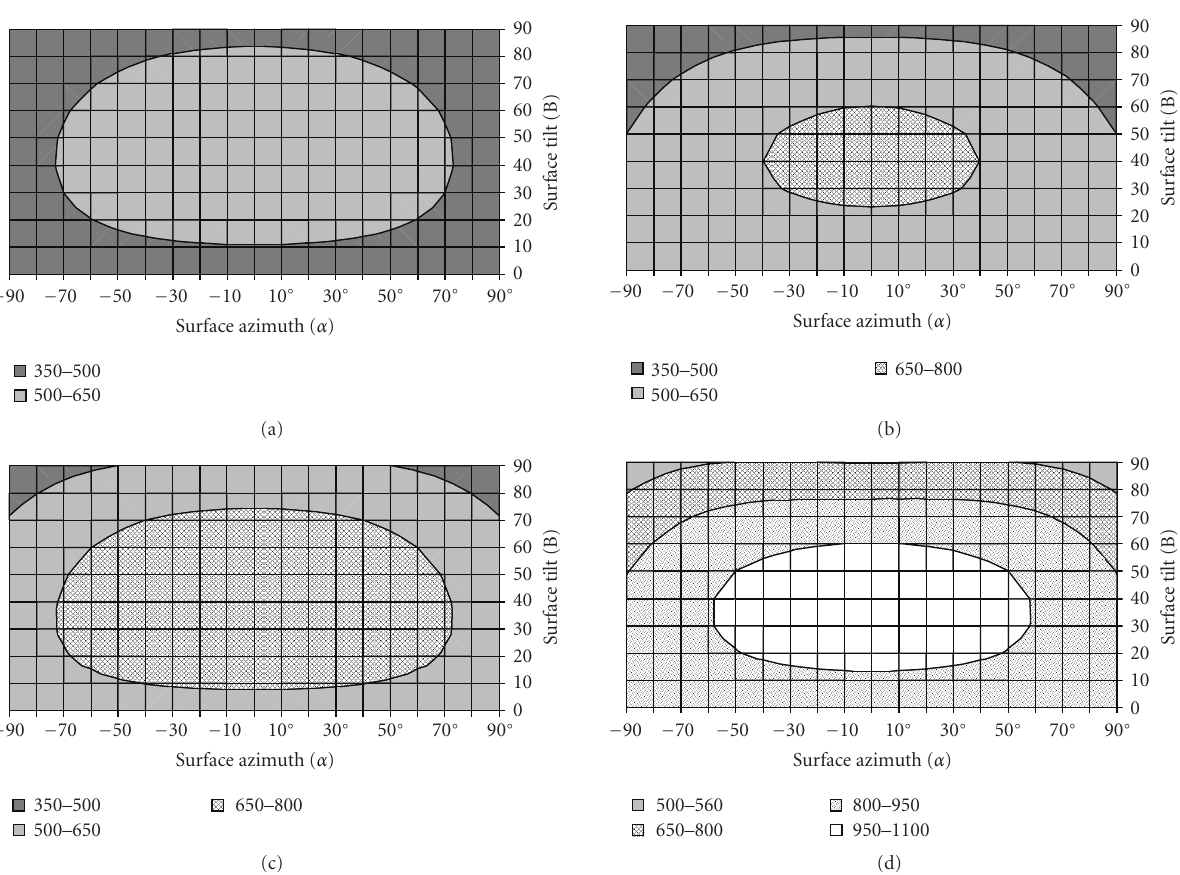
Figure 1: Cell RMS current (mA) for di ff erent orientations and European locations. (a) Bergen-Norway, (b) Bonn-Germany, (c) Paris- France, (d)